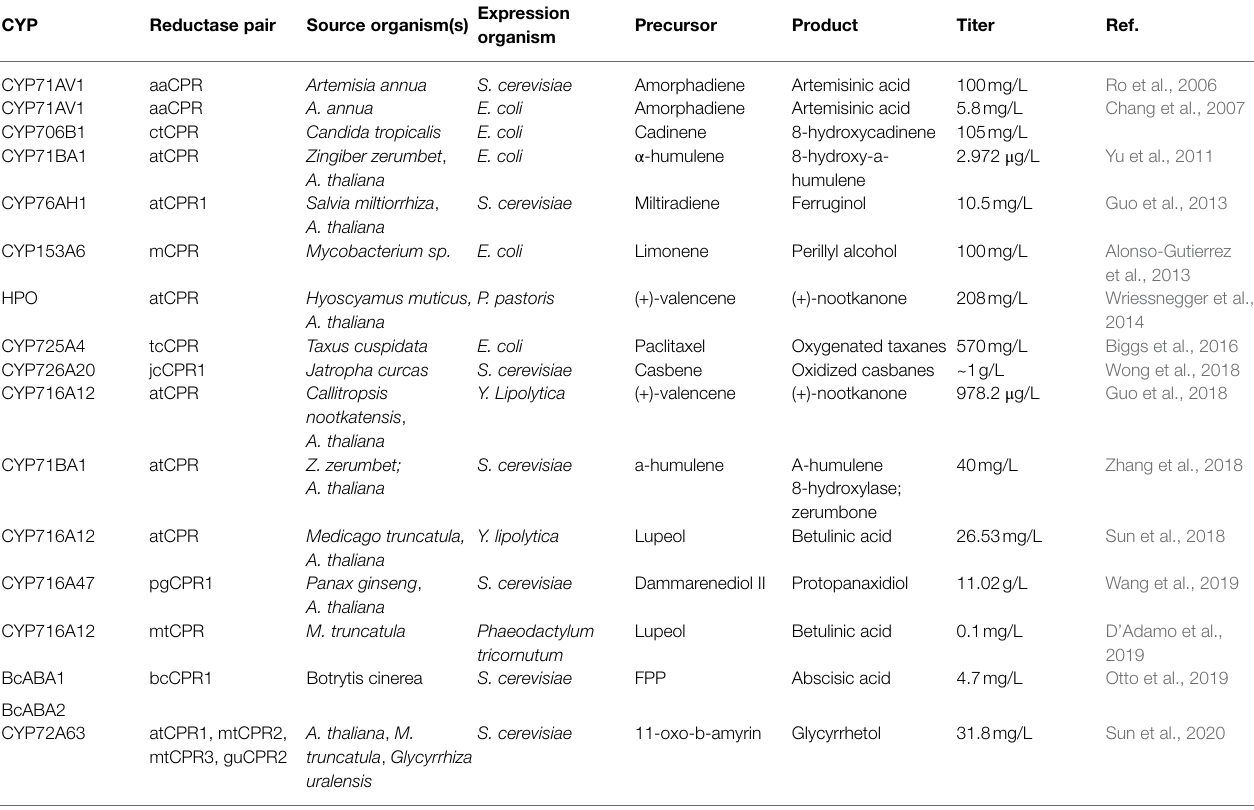
TABLE 1 | CYP expression, reductase pairing, and production of oxygenated terpenoids in various microbial hosts.